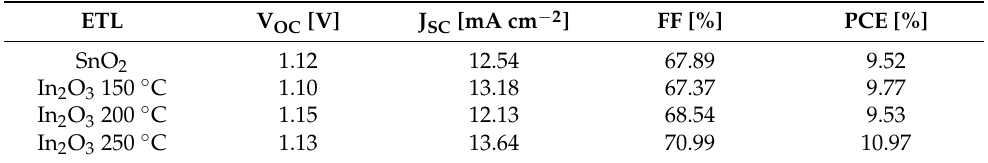
Table 1. The corresponding current density-voltage (J-V) curves are shown in Figure 8c. Table 1. Photovoltaic parameters of CsPbI 2 Br PSCs with SnO 2 nanoparticles ETL and ALD-In 2 O 3 ETLs deposited at 150 ◦ C, 200 ◦ C, and 250 ◦ C under AM1.5 illumination.